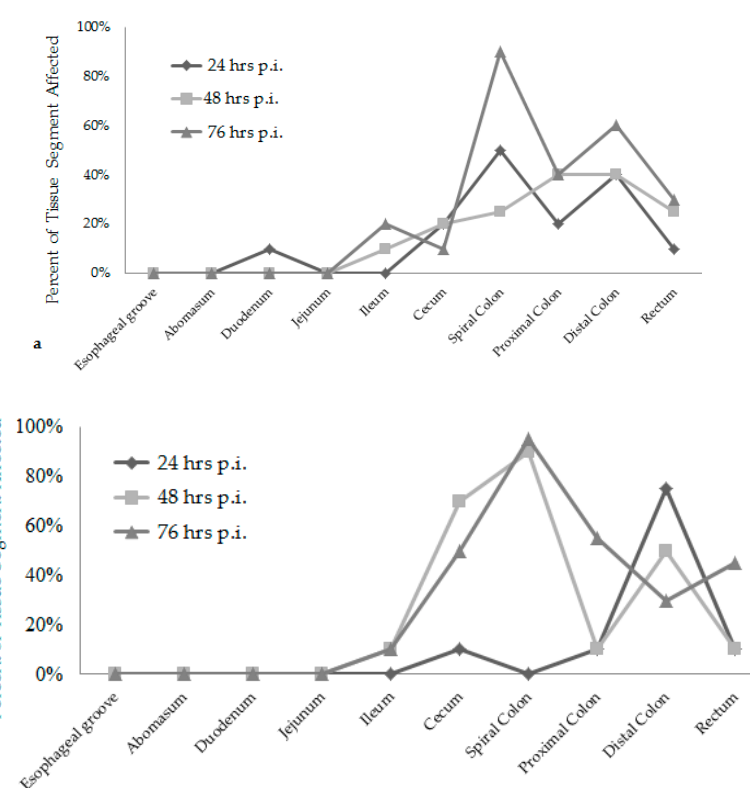
Figure 3. Percent of the total intestinal tissue segment affected at each time increment for the wildlife E. coli O157:H7 inoculum group of calves ( a ). Percent of the total intestinal tissue segment affected at each time increment for the bovine E. coli O157:H7 inoculum group of calves ( b ). (hrs) hours; (p.i.) post-inoculation.